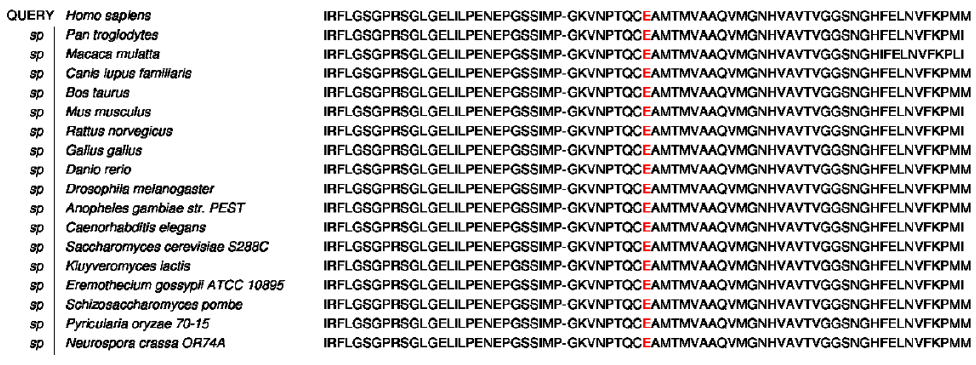
Figure 6. The missense mutation c.1132G > A (p.E378K) in exon 8 is highly conserved among 17 species.